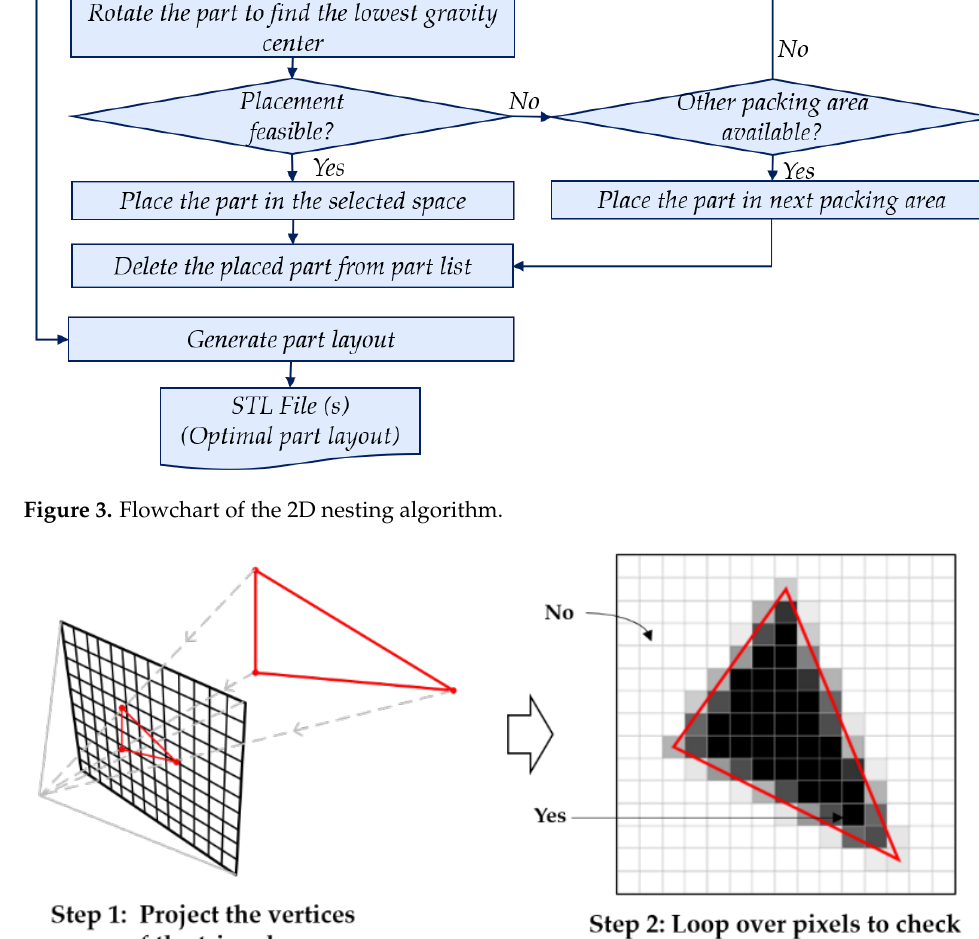
Figure 4. Two-step procedure of the raster